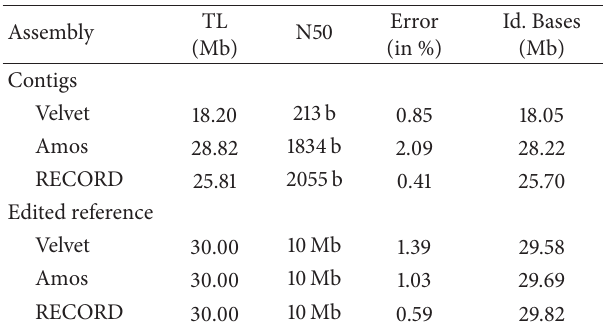
Table 1: Evaluation on simulated